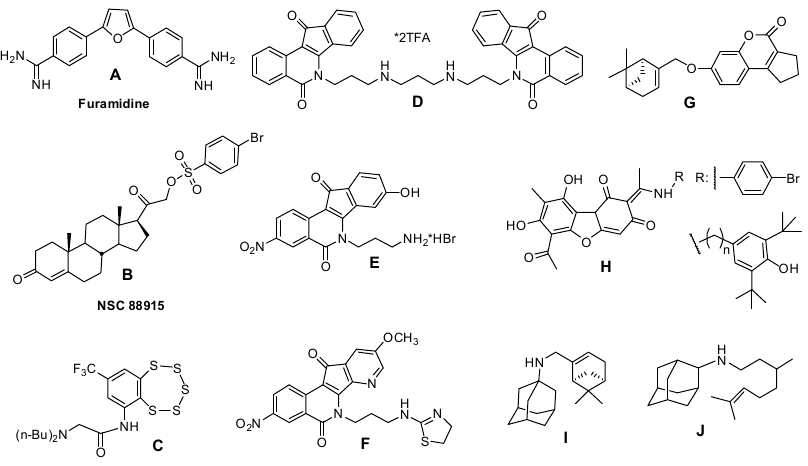
Figure 1. Structures of reported Tdp1 inhibitors.